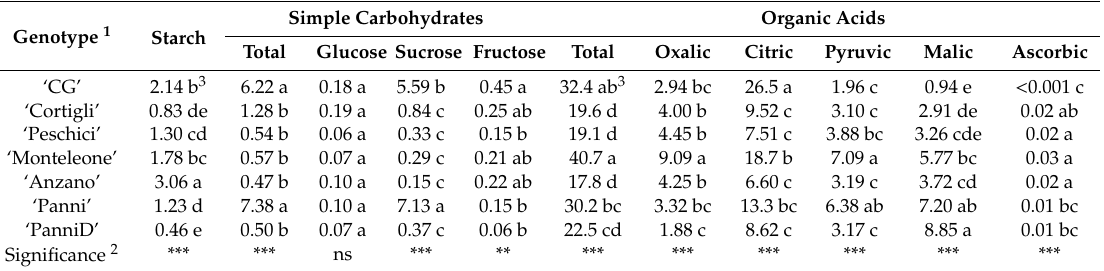
1 Refer to Table 1 for acronyms of garlic genotypes. 2 Significance—ns and **, *** not significant or significant at p ≤ 0.01 and p ≤ 0.001, respectively. 3 Di ff erent letters within the column indicate significant di ff erences at p = 0.05. Genotypes di ff ered distinctively in the amount of total carbohydrates and individual soluble − 1 sugars, except for glucose (0.11 g kg dw, on average). ‘Panni’, as well as the CG, showed the